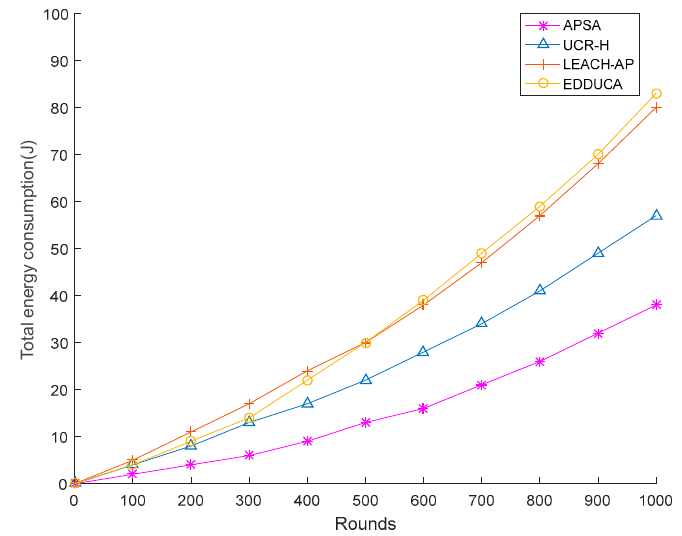
Figure 5. Energy consumption between different algorithms (50 sensor nodes).